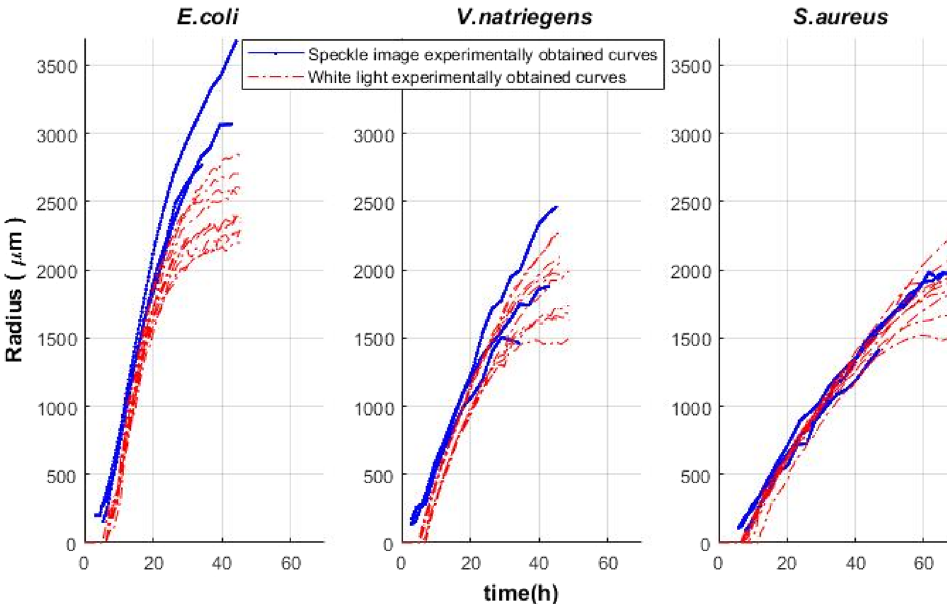
Figure 3. Dynamics of colony growth radius over time. The colony radiuses of E. coli, V. natriegens and S. aureus were measured by laser speckle image analysis (blue) or considering images taken by flatbed scanner (Canon 4400, 600 DPI) (red).